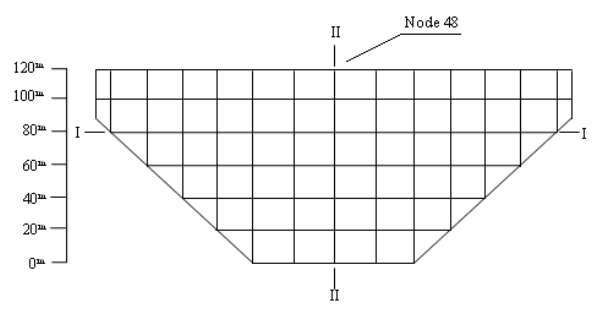
Fig. 4. Finite element model of downstream face of the dam.